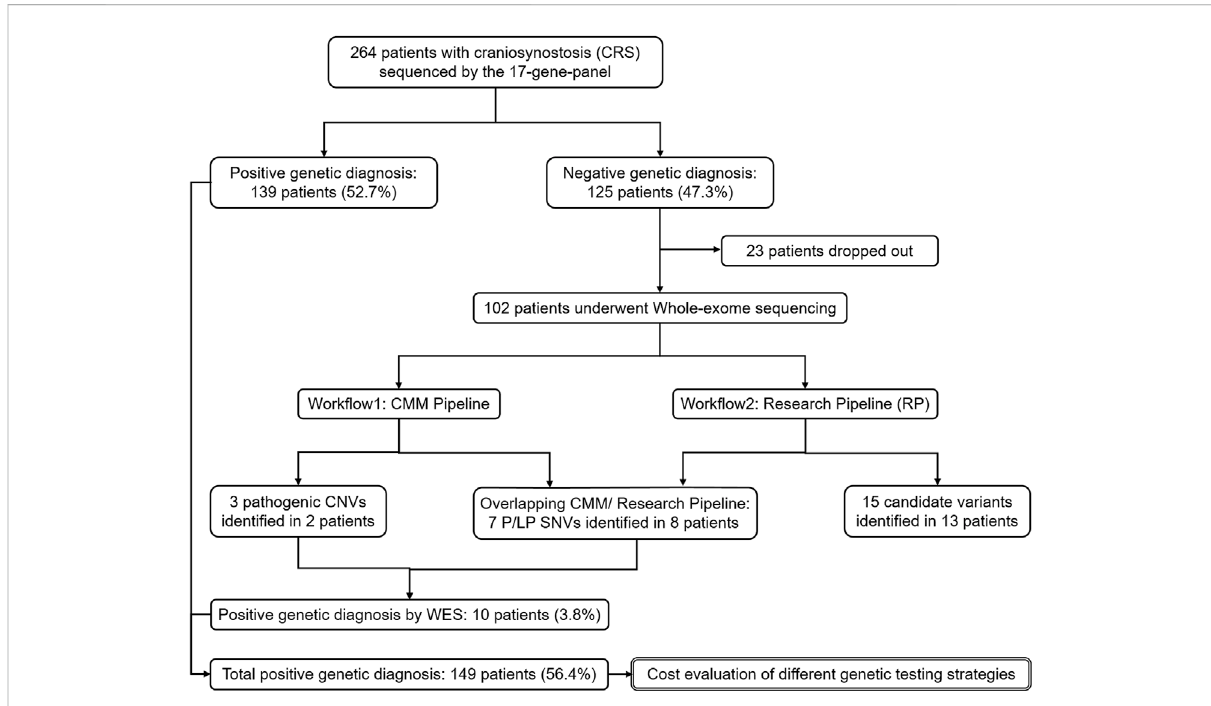
FIGURE 1 The framework of the whole study. Analyses on the genetic diagnosis and variants identi fi cation are in single solid line box. Analysis on the economic cost is in double solid line